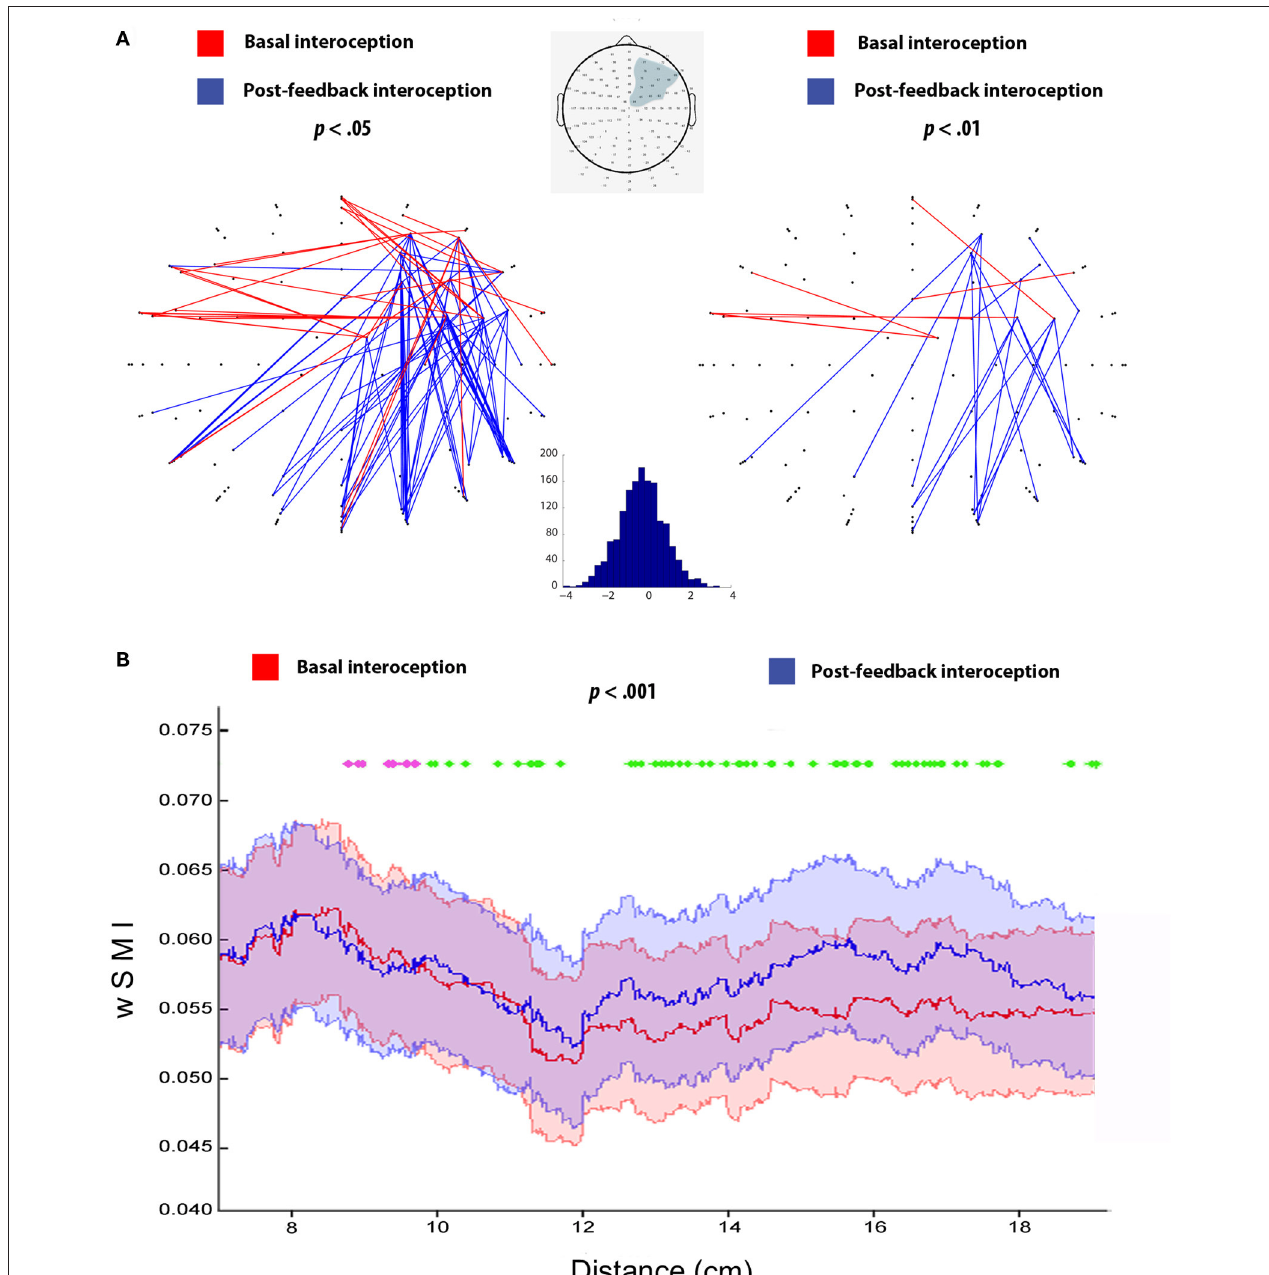
FIGURE 3 | (A) Connectivity analysis for basal and post-feedback interoception at p < 0.05 and p < 0.01, following previous studies (Canales-Johnson et al., 2015). Red lines indicate connections that are significantly higher for basal interoception and blue lines represent enhanced connections for post-feedback interoception, both at the 10–20 Hz frequency band ( τ = 16 ms). The gray shadow in the scalp diagram delimits the selected ROI used for the analysis. The histogram indicates t -values distribution from the comparison between basal ( > 0) and post-feedback interoception ( < 0). (B) wSMI as a function of inter-channel distance for basal and post-feedback condition ( p < 0.001, as in King et al., 2013). Pink dotted lines show differences in favor of basal interoception for short distance connectivity, while green dotted lines indicate significant differences in favor of post-feedback interoception for long range connectivity; ( p < 0.001). The X axis shows Euclidian distance in cm based on Channel Location coordinates (King et al., 2013). The color shadows plotted indicates the SEM of each condition.